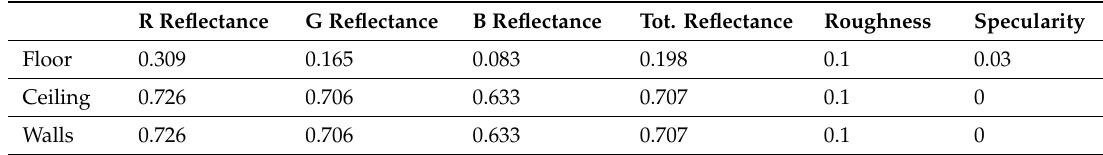
Table 6. Surface parameters of floor, ceiling and walls.